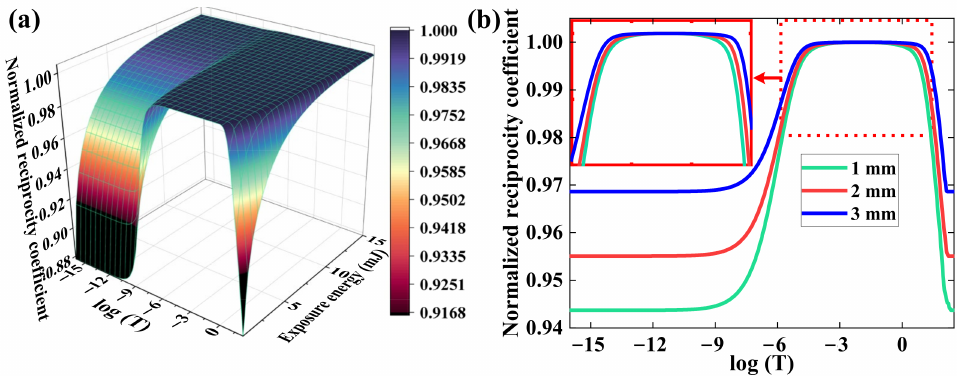
Figure 3. The evolution of normalized reciprocity coefficient with ( a ) different exposure energy (0–15 mJ), and ( b ) different material thickness (1–3